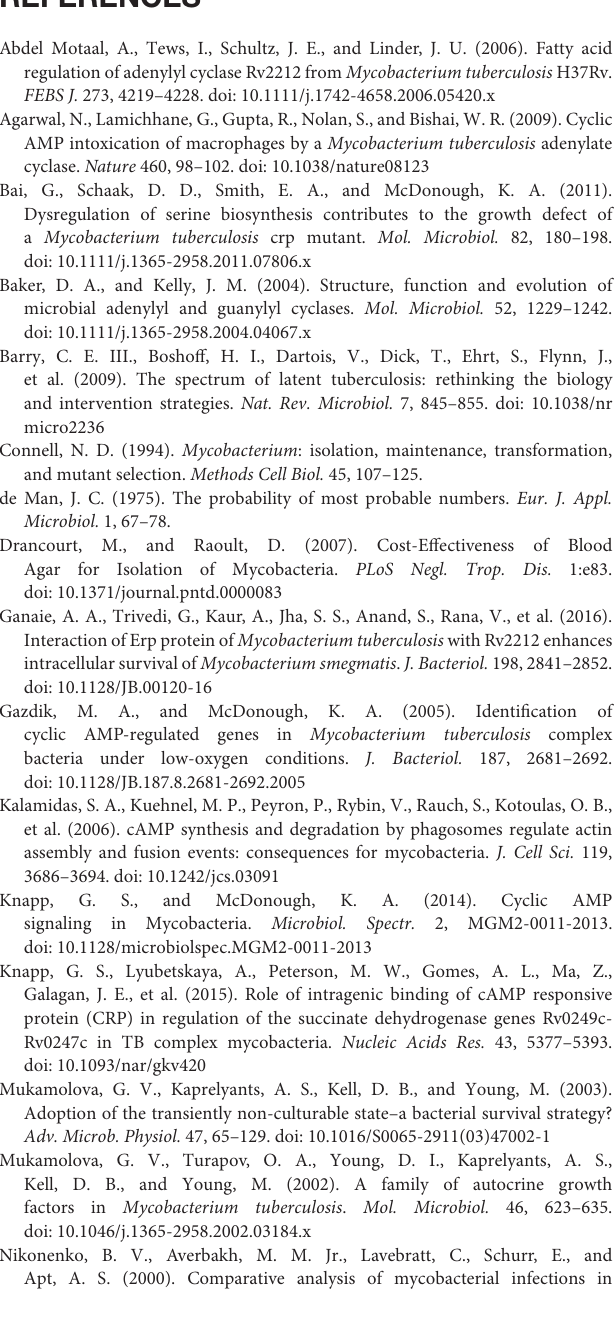
agitation (200 rpm) at 37 ◦ C for 8 days. In some experiments, tetracycline hydrochloride was added to medium at the final concentration 20ngperml. Results display the average from three independent experiments. Figure S2 | Growth of different M. tuberculosis strains in the standard Sauton’s medium from the 10 5 inoculum. Recombinant M. tuberculosis